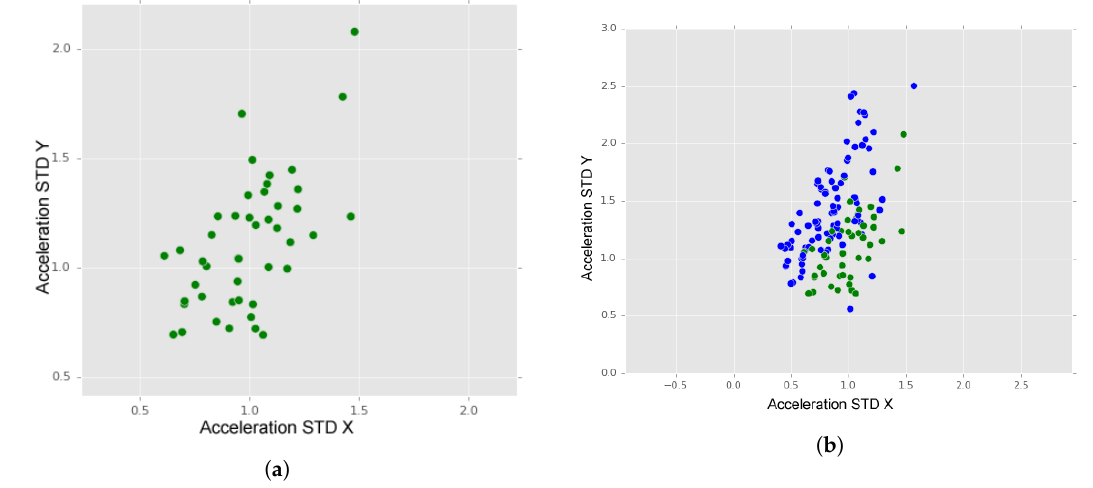
Figure 12. ( a ) Manholes; and ( b ) manholes (green dots) and bumps (blue